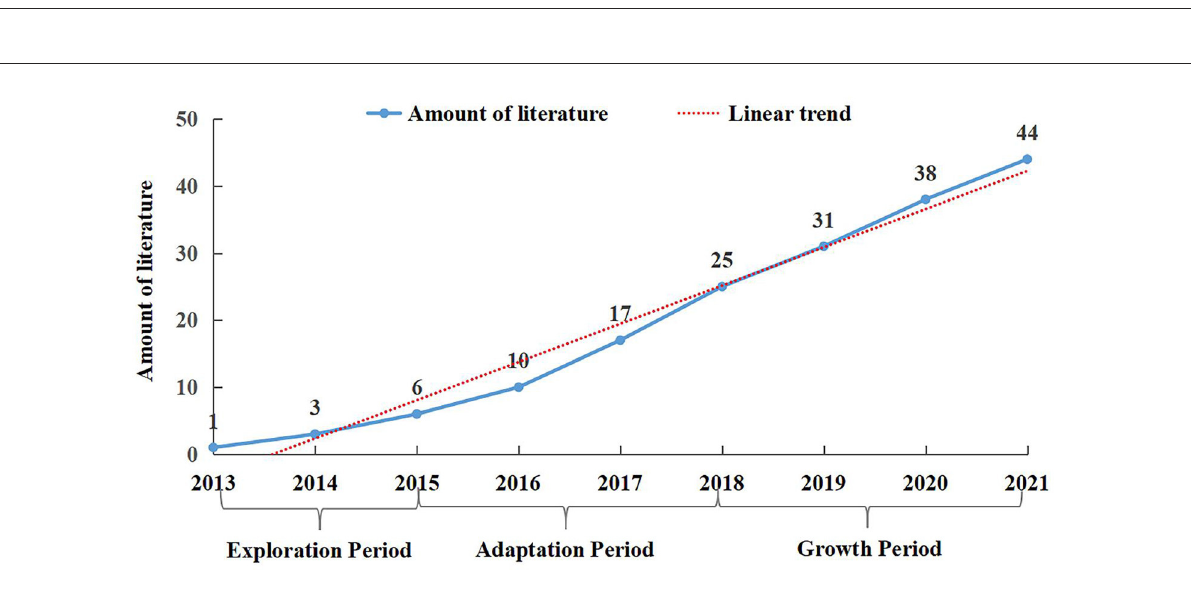
FIGURE2 Annual publications of review literature